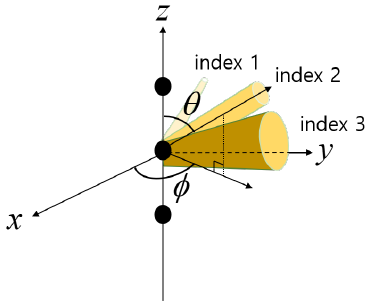
Figure 6. The example of predesigned beam patterns at the antenna